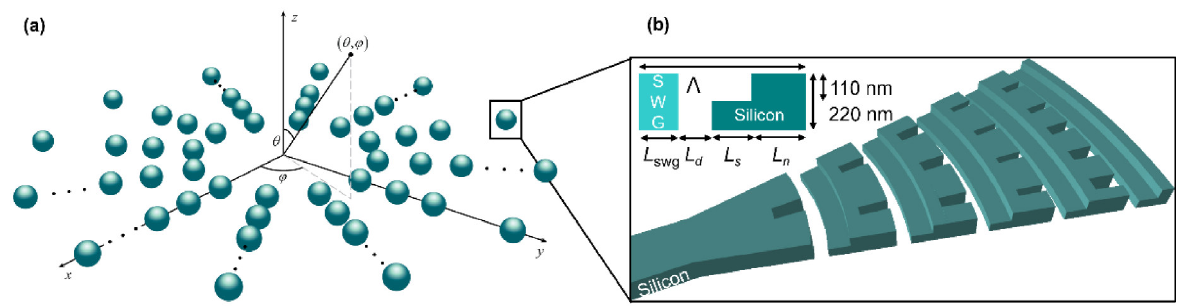
Figure 1. ( a ) Schematic of a two-dimensional circular optical phased array. The green spheres represent individual nano-antennas. ( b ) Three-dimensional schematic of a silicon-based surface-emitting antenna. Inset: Two-dimensional side view of the single antenna period with L -shaped radiating segments.